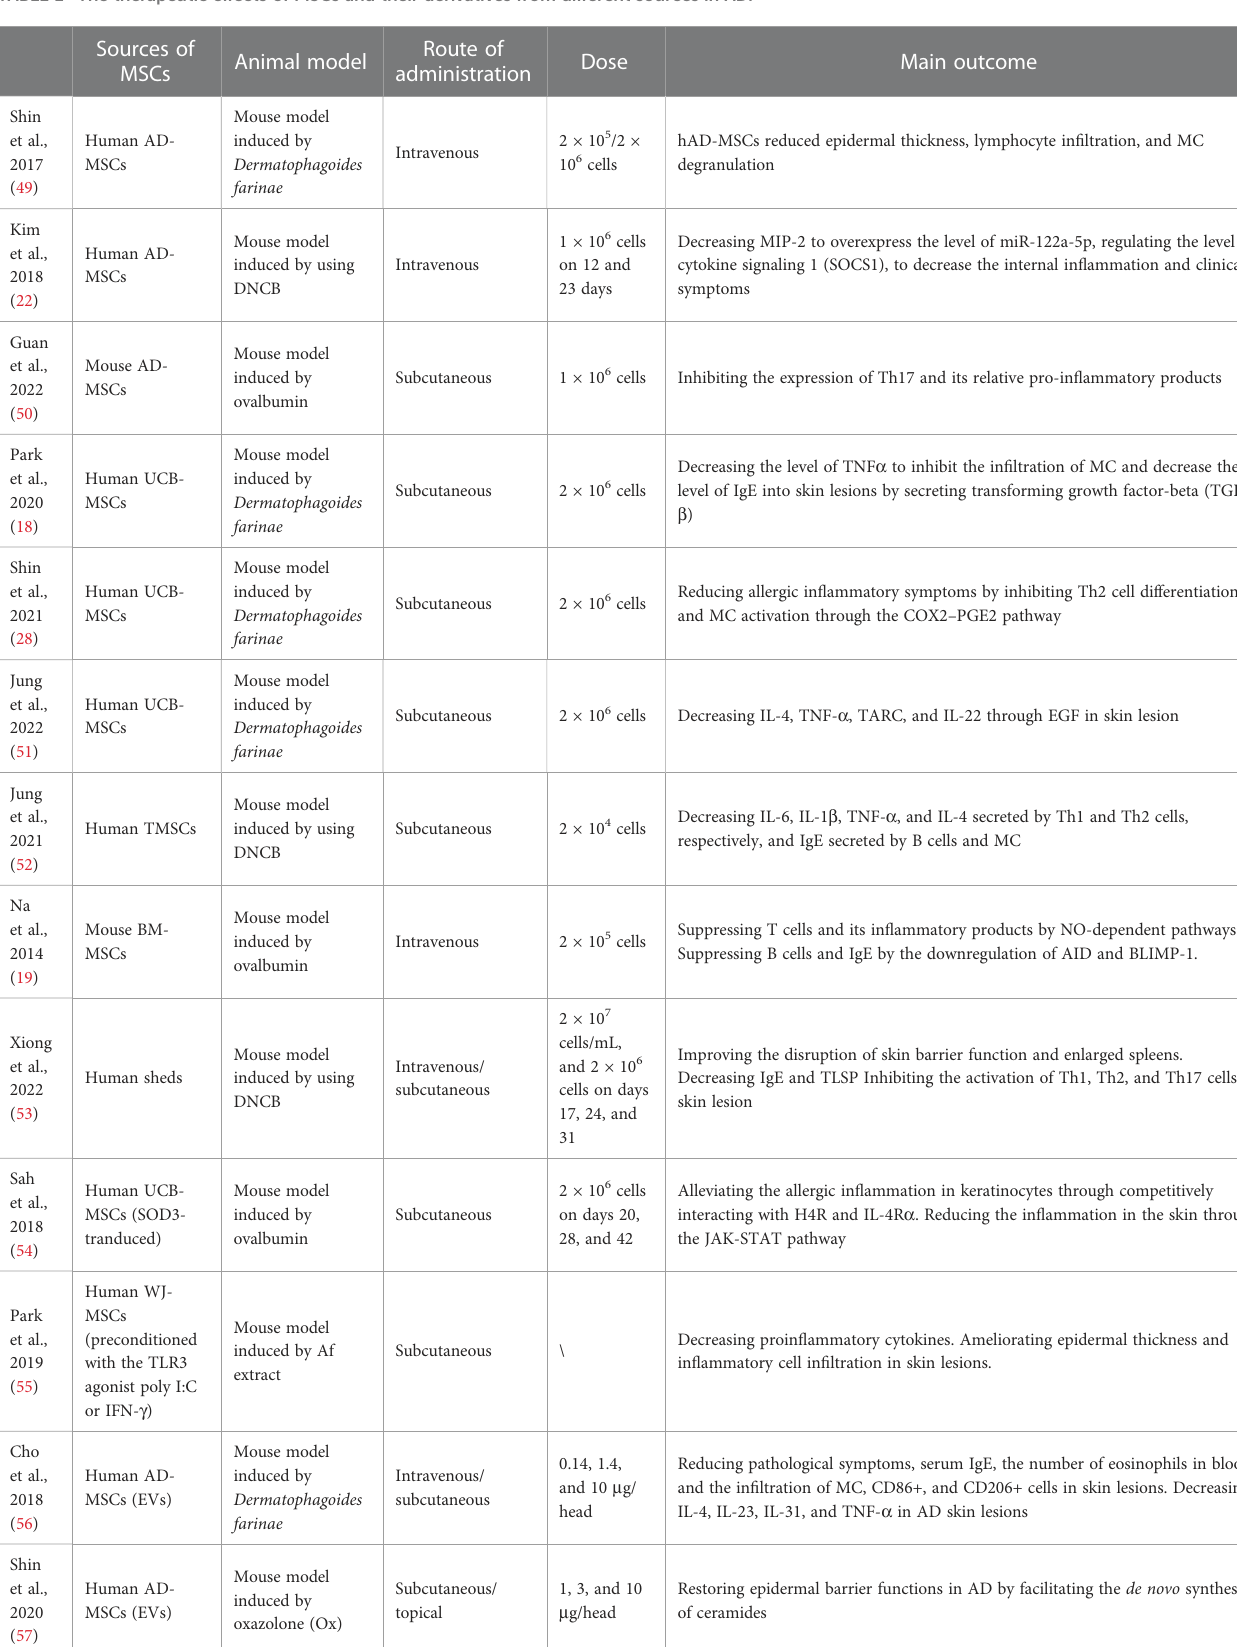
TABLE 1 The therapeutic effects of MSCs and their derivatives from different sources in